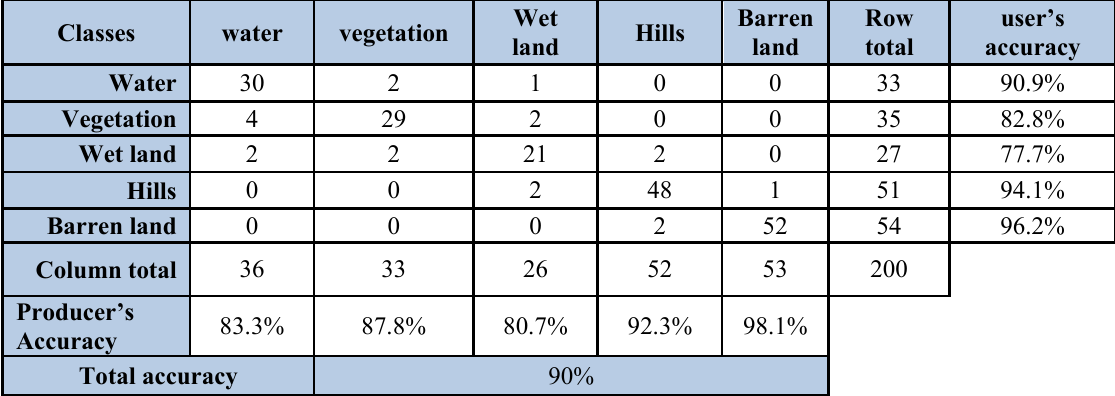
Table 10: Error matrix with producers, users, and overall accuracy calculations for supervised classification using SVD for Landsat-8